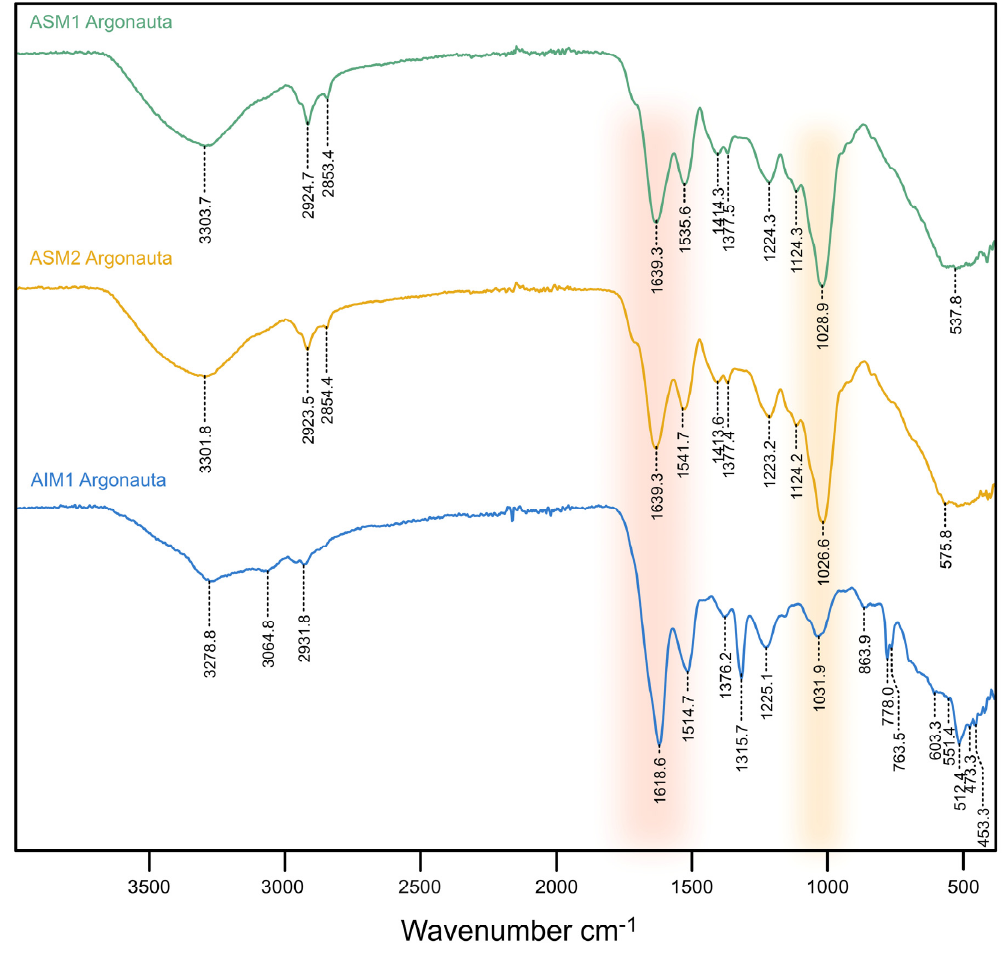
Figure 4. FT-IR spectra of three shell extracts acquired in Attenuated Total Reflectance mode (ATR). Note that the two ASMs, in spite of the extended bleaching treatment for ASM2, are almost superimposable. Due to low quantity, AIM2 could not be